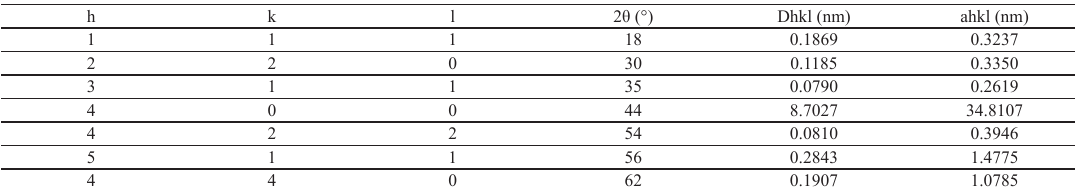
Table 7. Lattice Parameters Calculation and Cubic Crystal Grid Spacing a . Considering n = 1 and λ = 1.54060 Å. h